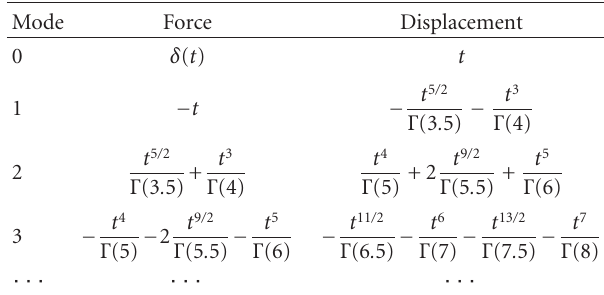
Table 2: Modal force and displacements for second-order system with fractional order